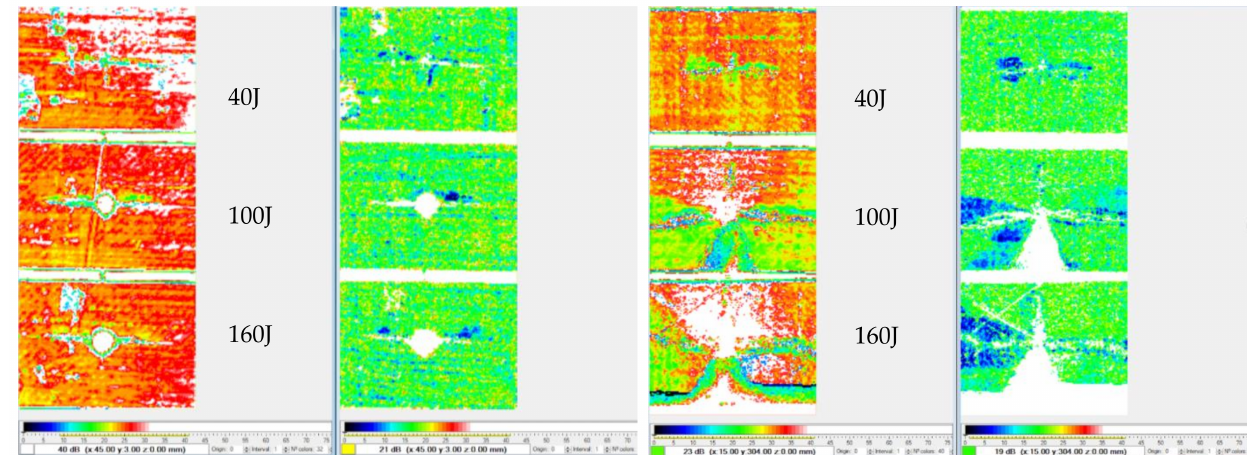
Figure 3. The laminated T700/PPS ( left ) and T700/PA6.6 ( right ) specimens post impact.